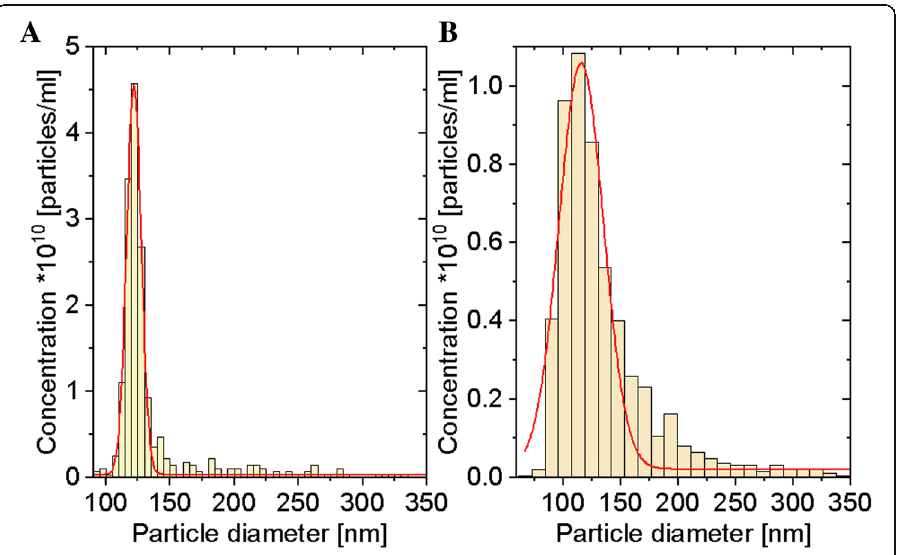
Fig. 2 Size distribution of EVs derived from the TIME cell line ( a ) and the HUVEC line ( b